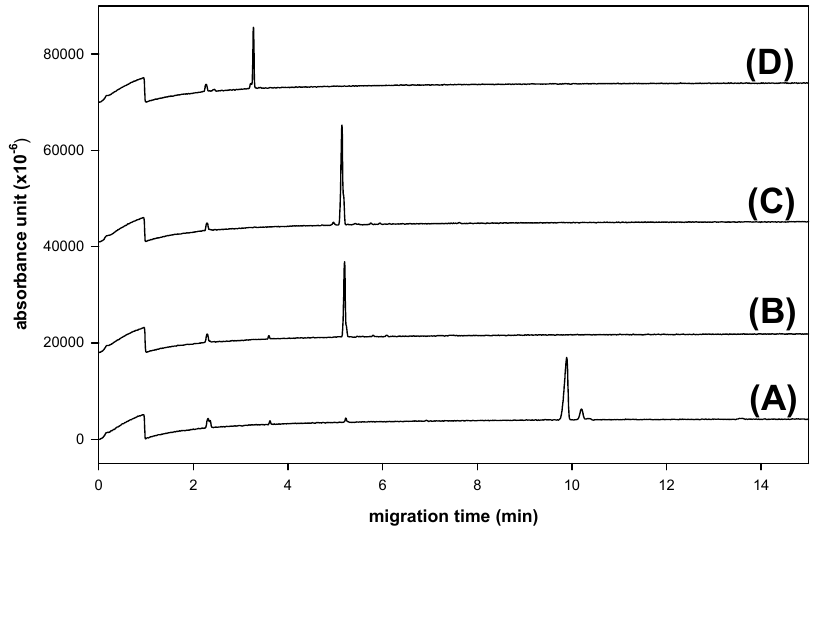
Figure 4. CE analysis of heparin disaccharide-NAIMs: ( A ) α - ∆ UA-2S-[1 →